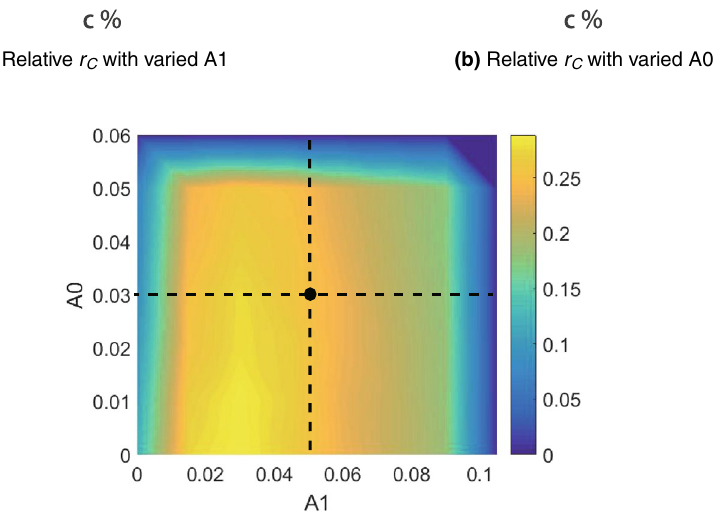
The curves’ slope in Fig. 5a and b reflect the coding capability of confidence neurons. A slope of zero means the confidence neurons have the same firing rates given stimuli with different coherence levels, which implies that confidence neurons cannot code the decision confidence. Larger slopes indicate larger difference in confidence neurons’ firing rates between stimuli with different coherence levels, which means that confidence neurons are more sensitive to the changes in confidence. Figure 5c shows the dependence of the slope on parameters A 1 and A 0 , where a horizontal dashed line is shown in Fig. 5a and vertical lines are shown in Fig. 5b. These results